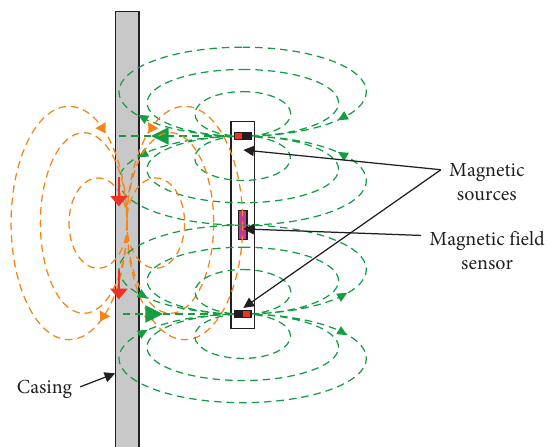
Figure 1: Distribution of magnetic line around probe with casing.